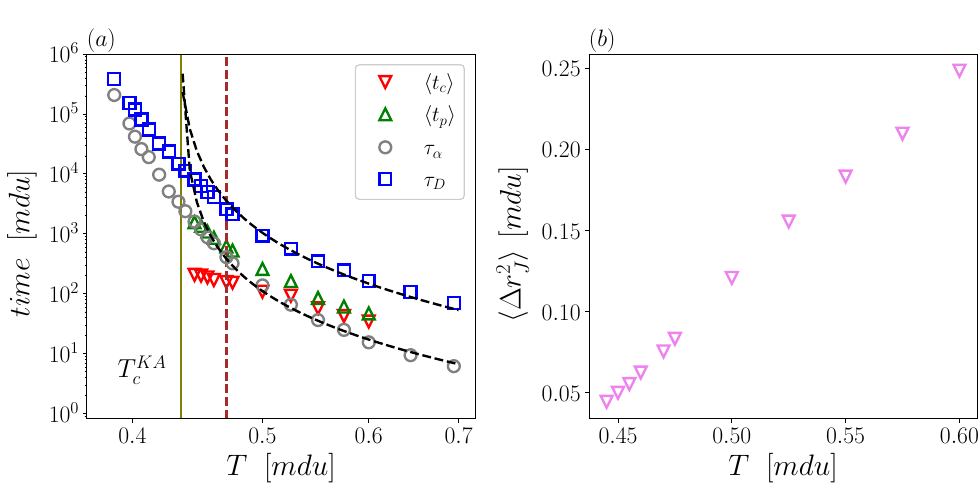
Figure 1. ( a ) Macroscopic ( τ α and τ D ) and microscopic ( temperature. Dashed lines are MCT-like fits ( T γ = 2.0 for τ D . Fitting parameters are taken from [3,44]. Green vertical solid line represents the critical temperature T KA c , red vertical dashed line marks T = 0.47. ( b ) Mean square jump length ∆ r 2 as a function of J (cid:105) (cid:104)